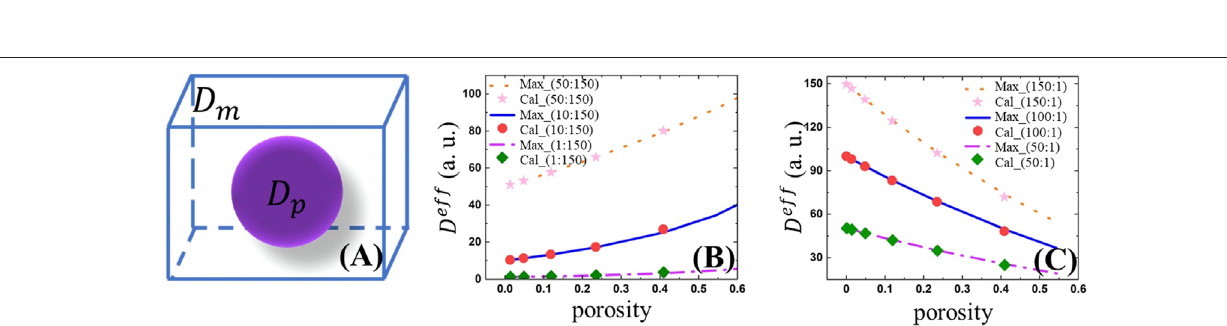
FIGURE1| Atwo-phasesystemwithasimpleslabstructure (A) parallelwitheachother,and (B) intersectwitheachother. (C) Comparisonbetweenthecalculated and theoretical effective diffusion coef fi cients as a function of the slab width for structure (A) , and (D) for structure (B) . The diffusion coef fi cient in the matrix and slab phase is set as 15.0 and 1.0 in the same unit, respectively.